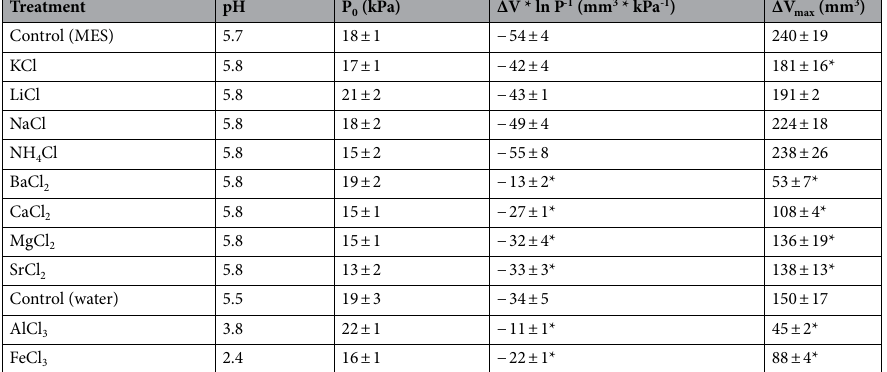
Table 9. Effect of various chloride salts on the in vitro swelling pressure (P 0 ), the change in cell wall volume per unit pressure (ΔV * ln P −1 ) and the maximum volume after swelling at 0.2 kPa (ΔV max ) of cell walls of mature `Burlat` sweet cherry fruit. Cell walls were extracted as the alcohol insoluble residue (AIR). All solutions were buffered using 10 mM MES and the pH adjusted to pH 5.8 using KOH or HCl. The only exceptions were AlCl 3 and FeCl 3 that were used without buffer. Buffer only served as control. The swelling pressure was calculated as the extrapolated x-axis intercept of a linear regression fitted through a plot of the change in AIR volume vs. the natural logarithm of the applied pressure (ln P). The change in AIR volume per unit pressure represents the slope of this regression and may be interpreted as a volumetric modulus of elasticity of the AIR. Data are means ± SE. *Mean comparisons within columns against the MES control by Dunnett test, p < 0.05. Only AlCl 3 and FeCl 3 were used un-buffered and hence, are compared with the water control by Dunnett test, p <